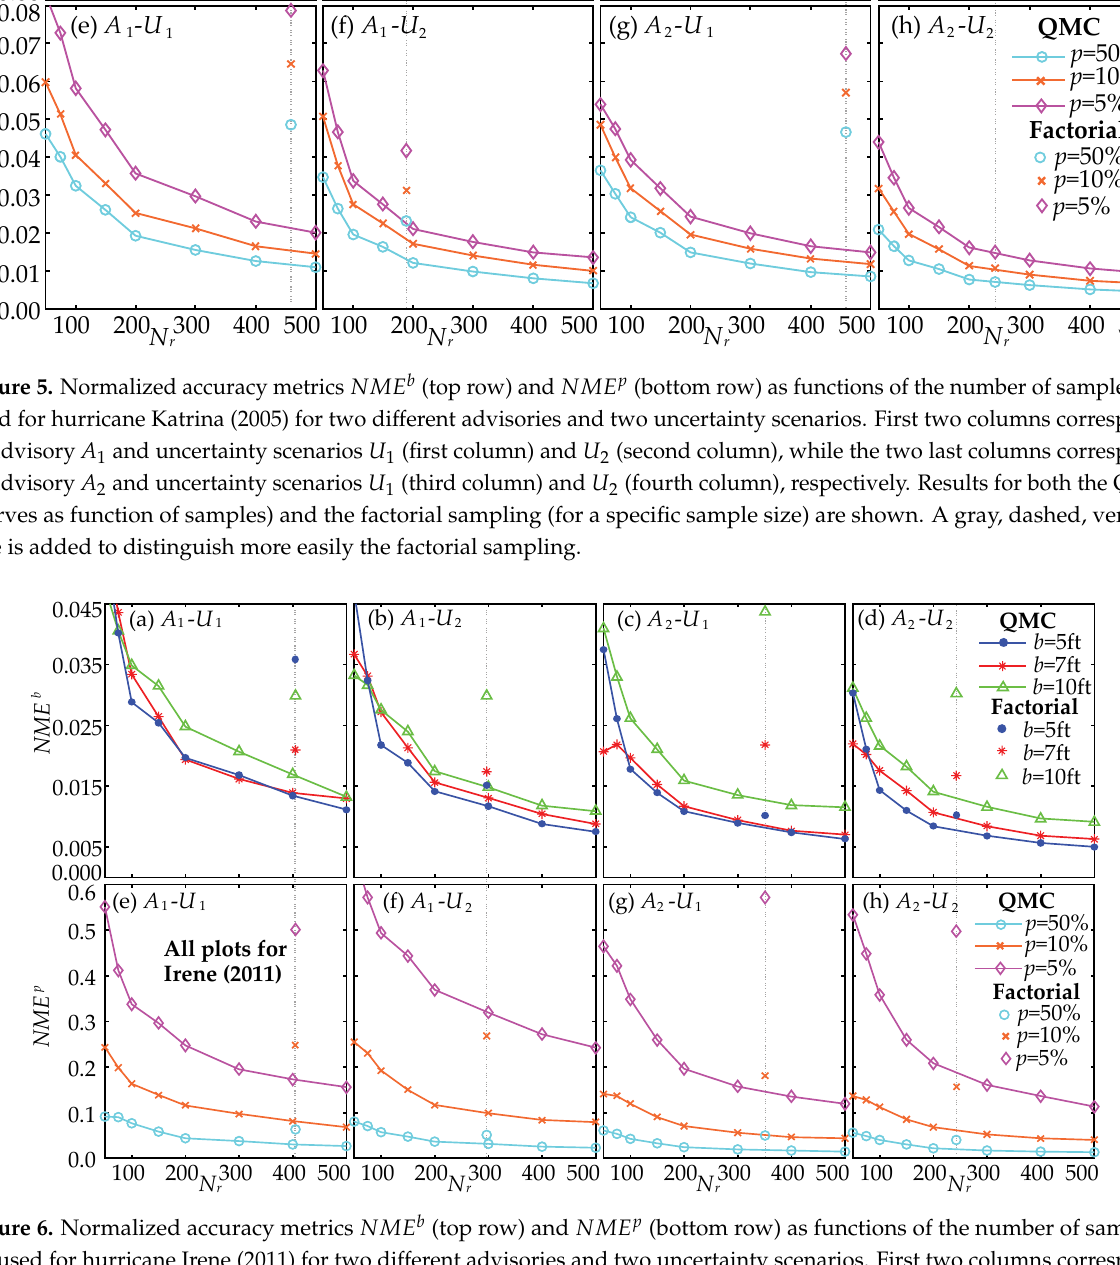
Figure 6. Normalized accuracy metrics NME b (top row) and NME p (bottom row) as functions of the number of samples N r used for hurricane Irene (2011) for two different advisories and two uncertainty scenarios. First two columns correspond to advisory A 1 and uncertainty scenarios U 1 (first column) and U 2 (second column), while the two last columns correspond to advisory A 2 and uncertainty scenarios U 1 (third column) and U 2 (fourth column), respectively. Results for both the QMC (curves as function of samples) and the factorial sampling (for a specific sample size) are shown. A gray, dashed, vertical line is added to distinguish more easily the factorial sampling.